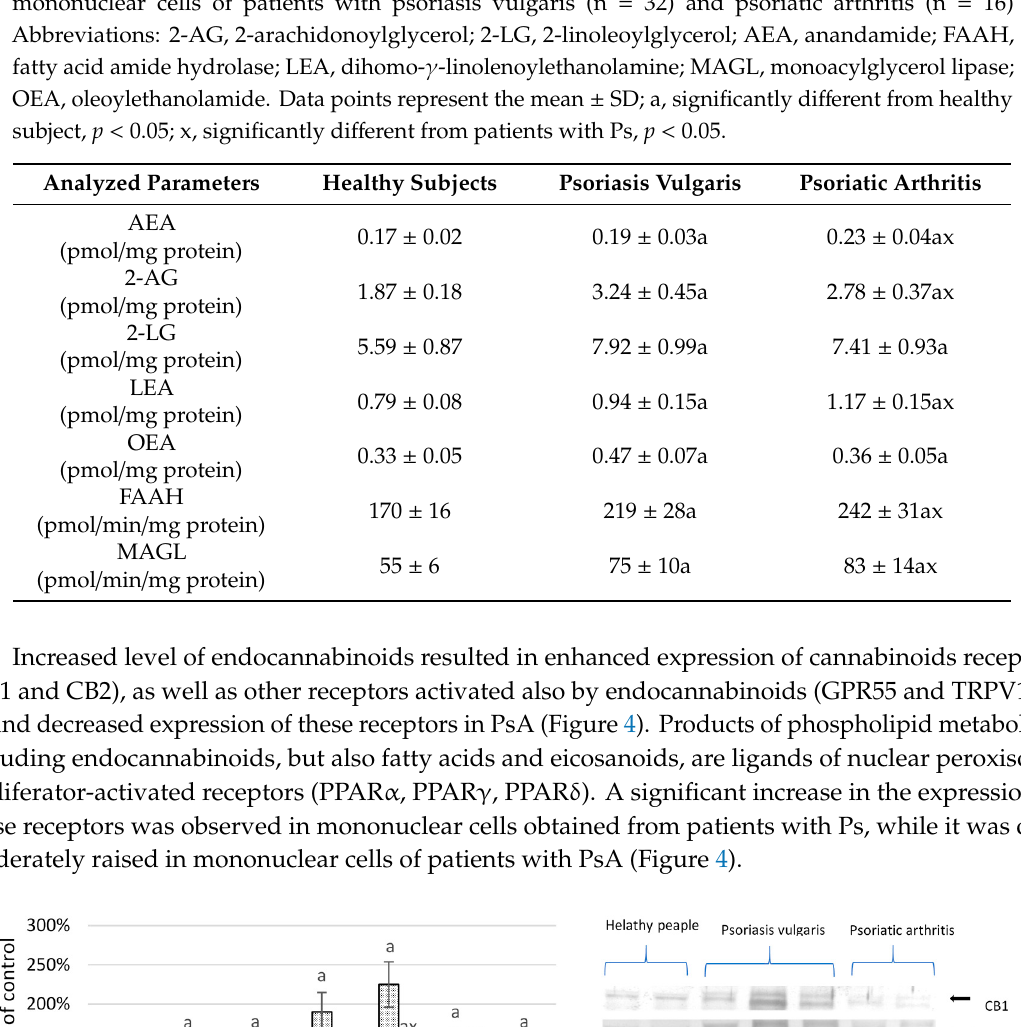
Figure 5. The level of the eicosanoids in mononuclear cells of patients with psoriasis (n = 32), psoriatic arthritis (n = 16), as well as healthy subjects (n = 16). Data points represent the mean ± SD; a, significantly different from healthy subject, p < 0.05; x, significantly different from patients with psoriasis vulgaris. Prostaglandin E1 (PGE1), leukotriene B4 (LTB4), 13-hydroxyoctadecadienoic acid (13HODE), thromboxane B2 (TXB2). Surprisingly, some of major eicosanoids 15-deoxy- Δ 12,14- prostaglandin J 2 (15-d-PGJ 2 ), 15-hydroxyeicosatetraenoic acid (15-HETE). Data points represent the mean ± SD; a, significantly different from healthy subject, p < 0.05; x, significantly different from patients with Ps, p < 0.05. Since psoriasis is known to be associated with inflammation, basic pro-inflammatory and anti- inflammatory parameters were examined (Figure 6). The levels of pro-inflammatory cytokine IL-2 was increased above normal in mononuclear cells of both forms of psoriasis, while anti- inflammatory IL-10 levels were not changed in psoriatic patients.